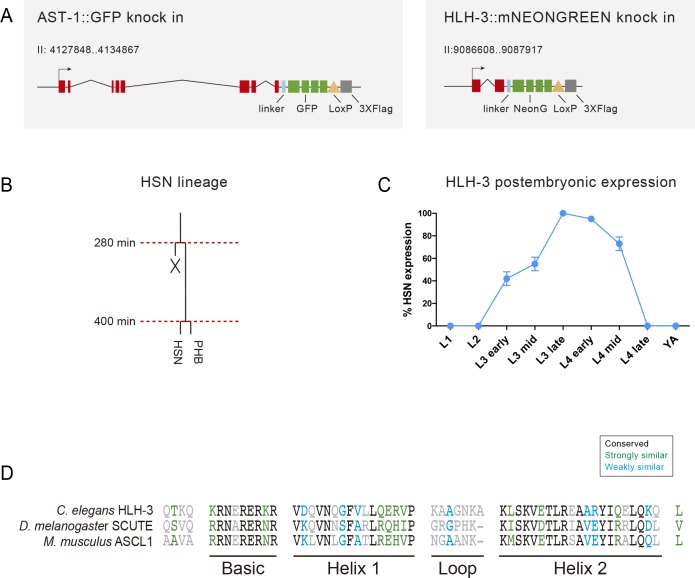
Dynamic HLH-3 expression in the HSN.(A) Schema of the modified ast-1 and hlh-3 locus to produce the corresponding fluorescent fusion proteins. (B) HSN lineage representation. (C) HLH-3 expression reappears postembryonically at L3 stage, peaks at late L3 and quickly disappears at the end of L4 stage. N > 100 cells each stage. (D) Alignment of the bHLH domain of C. elegans HlH-3, D. melanogaster SCUTE and M. musculus ASCL1 (EMBOSS Needle alignment tool default parameters). HLH-3 shows 48.3% identity and 63.8% similarity with SCUTE and 56.9% identity and 65.5% similarity with ASCL1.